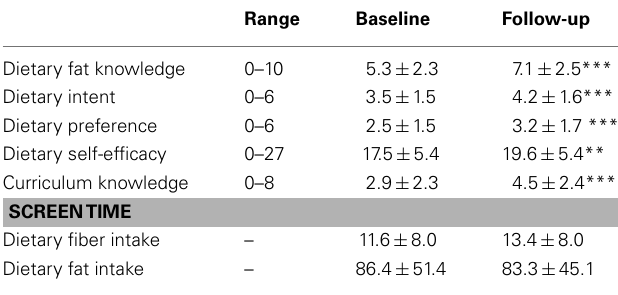
Table 1 | Knowledge and psychosocial factors results of the 1-year pilot of the Sandy Lake School-based Diabetes Curriculum intervention [adapted from Saksvig et al.